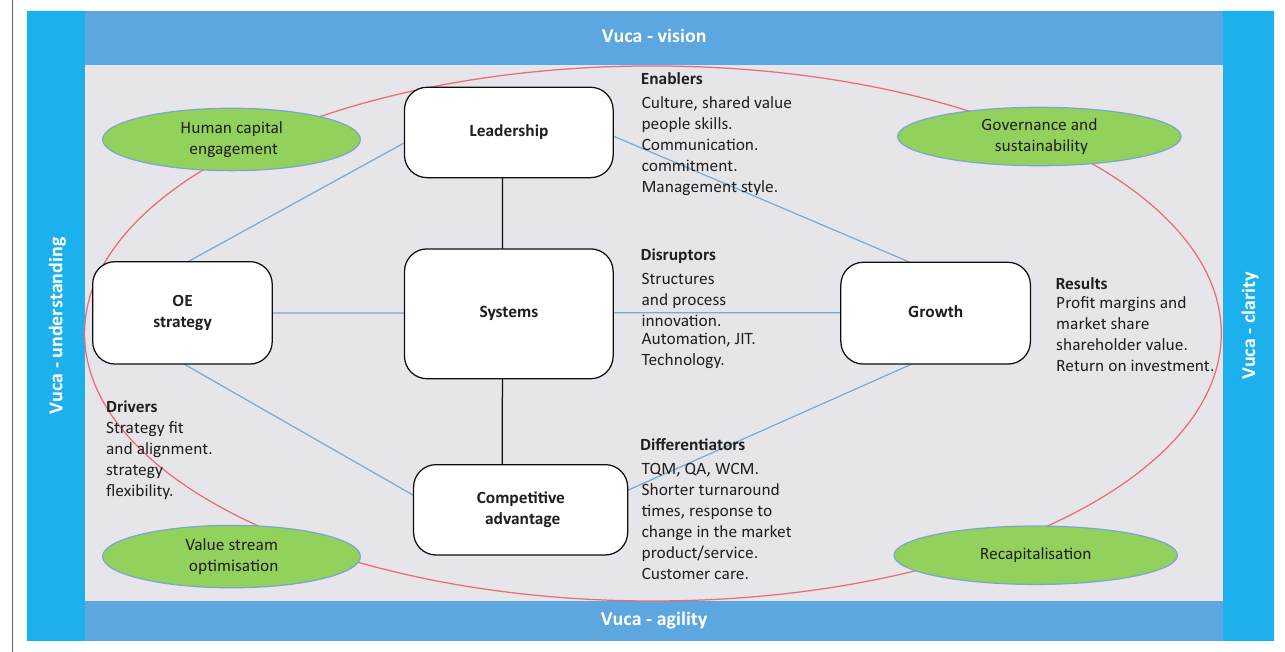
FIGURE 2 : Operational excellence model for growth in volatile, uncertain, complex and ambiguous